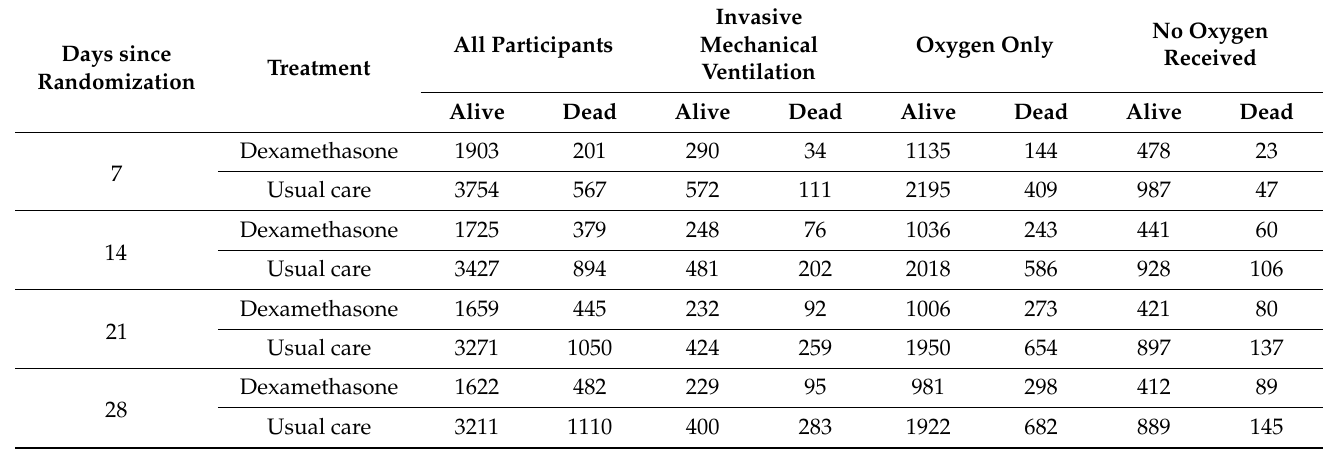
Table 1. Raw data concerning alive and dead patients extracted from the RECOVERY study at 7, 14, 21, and 28 days according with treatment and respiratory support in patients hospitalized with COVID-19.